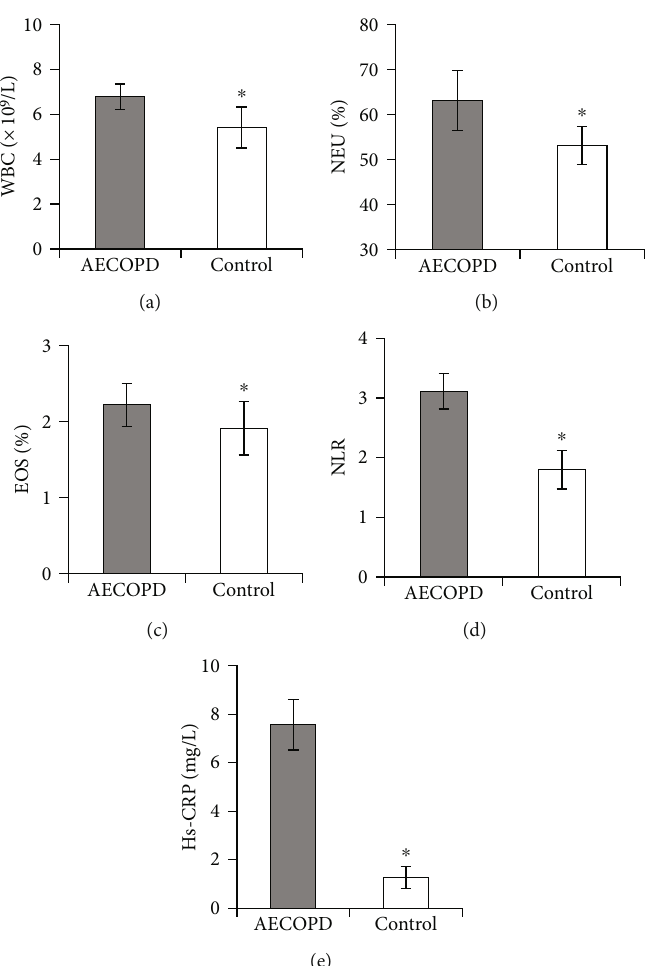
Figure 2: Comparison of blood routine in fl ammatory indicators in patients. Note: (a) WBC; (b) NEU; (c) EOS; (d) NLR; (e) Hs-CRP; there was clearly di ff erent from AECOPD group, ∗ P < 0 : 05